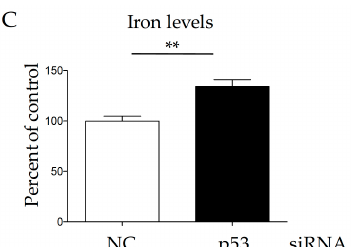
Figure 2. The effect of p53 knockdown on cellular iron level in HepG2 cells. HepG2-ZIP14-FLAG cells were used. Cells were incubated with negative control (NC) siRNA or p53-targeting siRNA #1 for 48 h. ( A ) cell lysates were analyzed by immunoblotting for p53. After stripping, blots were re- probed for ZIP14, TfR1, and β -actin; ( B ) to detect ferritin by immunoblot, cell lysates were incubated at 95 °C for 10 min before gel electrophoresis. Blots were first probed with anti-ferritin antibody. After stripping, blots were re-probed with anti-p53 and anti- β -actin antibodies; ( C ) cellular iron level was analyzed by Inductively Coupled Plasma Mass Spectrometry (ICP-MS). The amount of iron content was calculated as µg iron/ mg of protein. Data are normalized as percent of the iron levels of negative control siRNA transfected cells. Data represent three independent experiments.